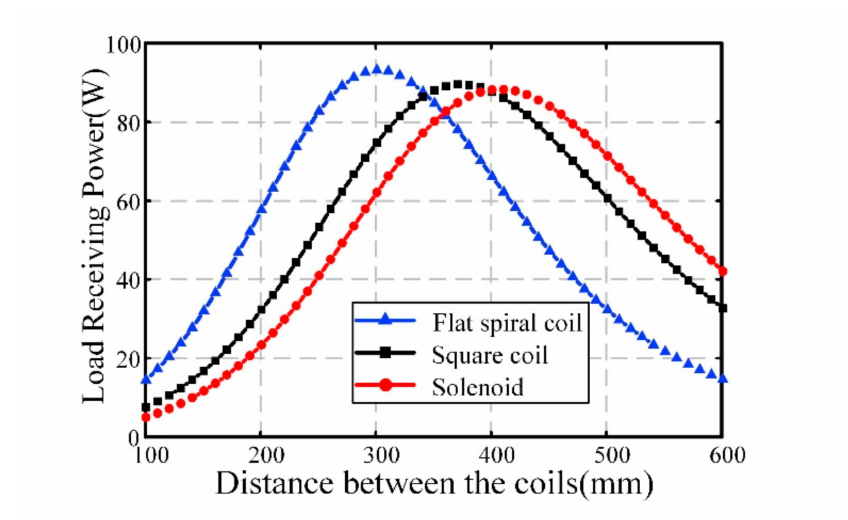
Figure 6. Load receive power of three systems with di ff erent types of coil at di ff erent